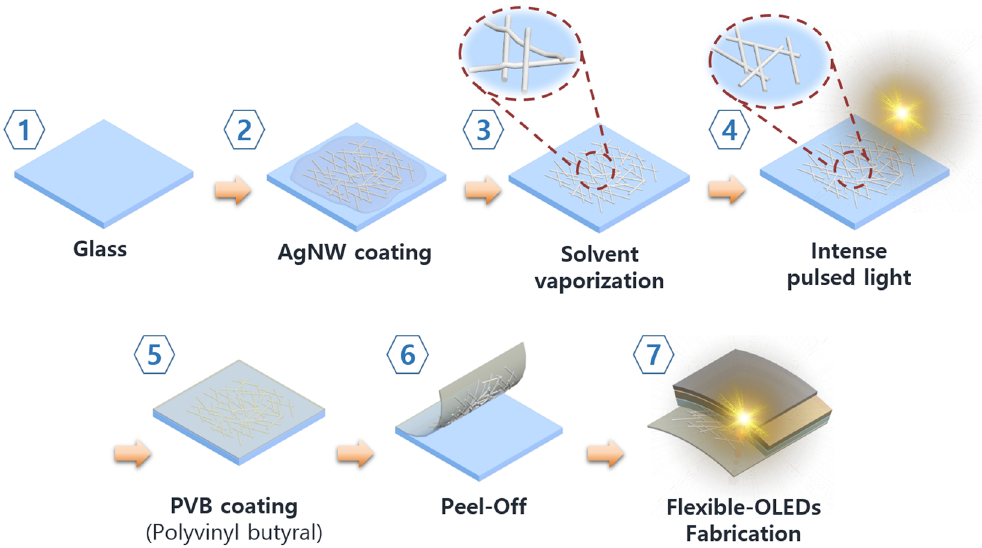
Figure 1. Schematic of PVB/AgNWs composite transparent electrode fabrication